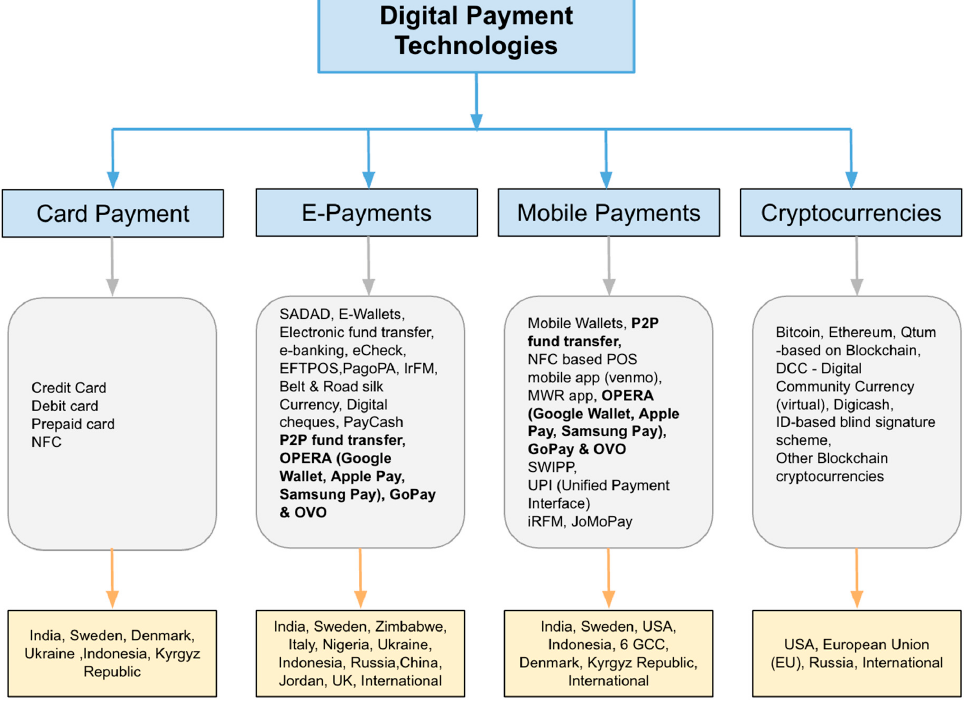
Figure 2. Emerging digital payment technologies with study location. Table 5. Empirical studies conducted on digital payment technologies.